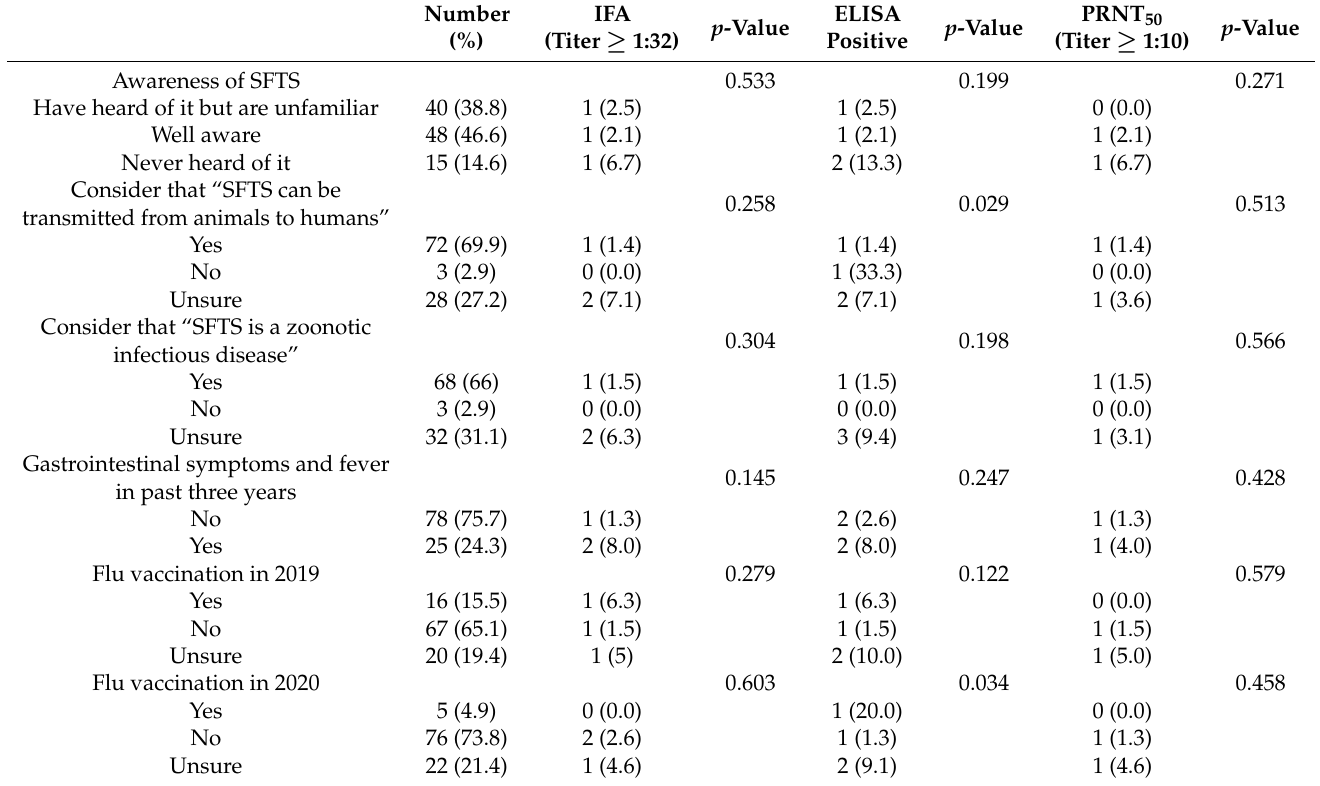
Table 3. SFTSV seropositivity according to the awareness of SFTS, gastrointestinal symptoms, and influenza vaccination in 103 veterinary hospital workers.